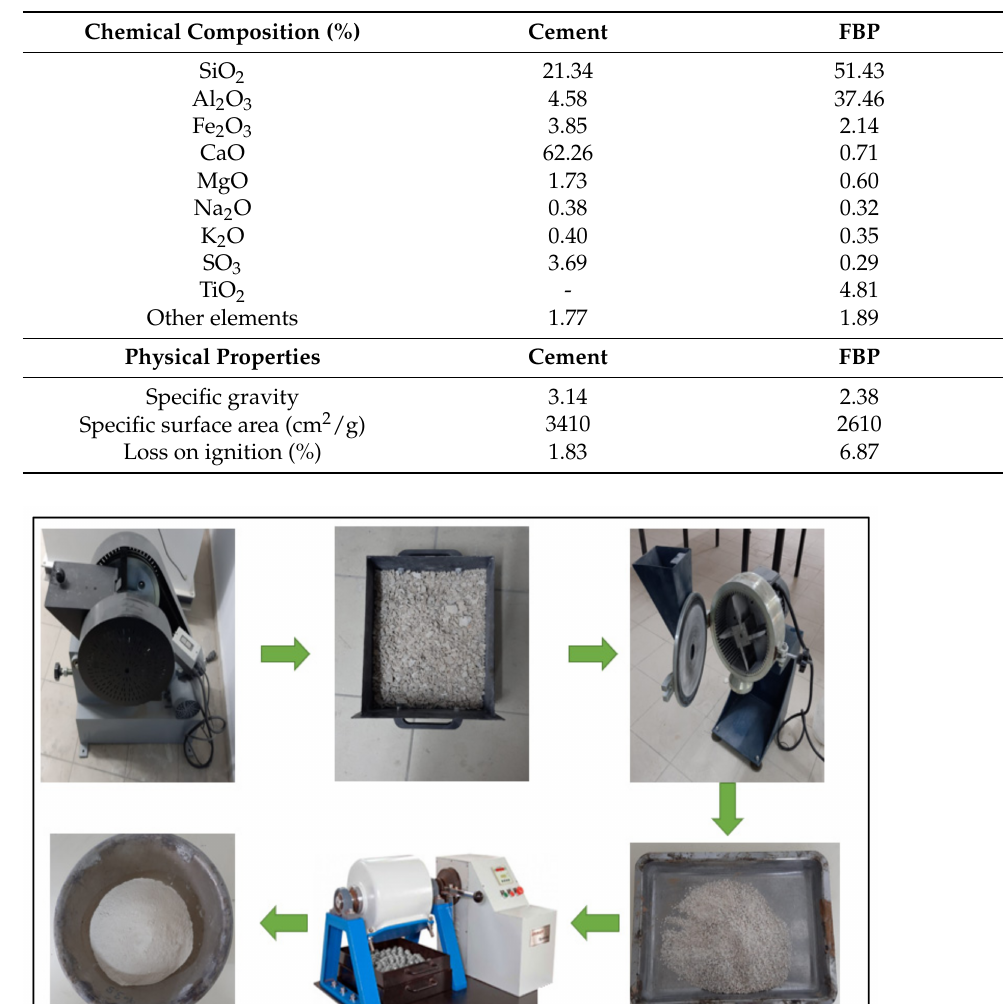
Table 1. Physical and chemical properties of cement and FBP.